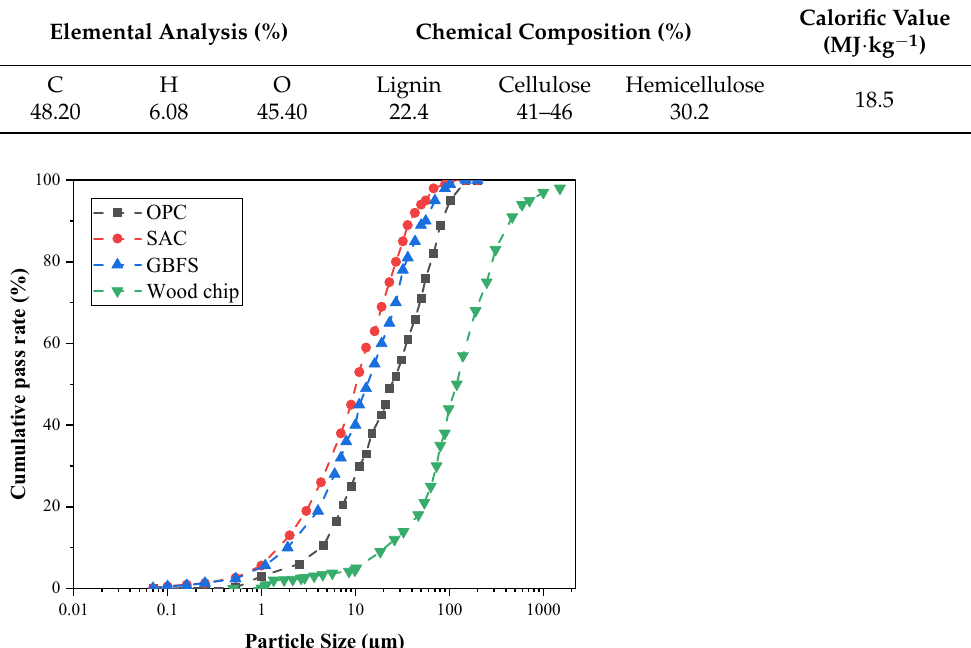
Figure 2. Cumulative particle size distribution curves of the pine wood chip and cementitious material.